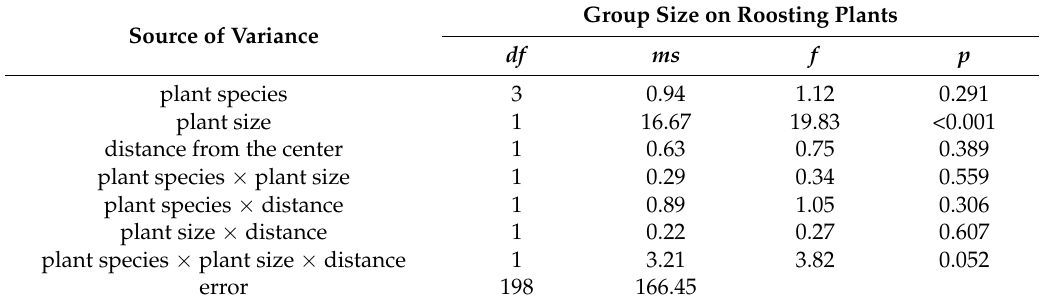
Table 2. Three-way analysis of variance for group size of gregarious Schistocerca gregaria nymphs on night-roosting plants.